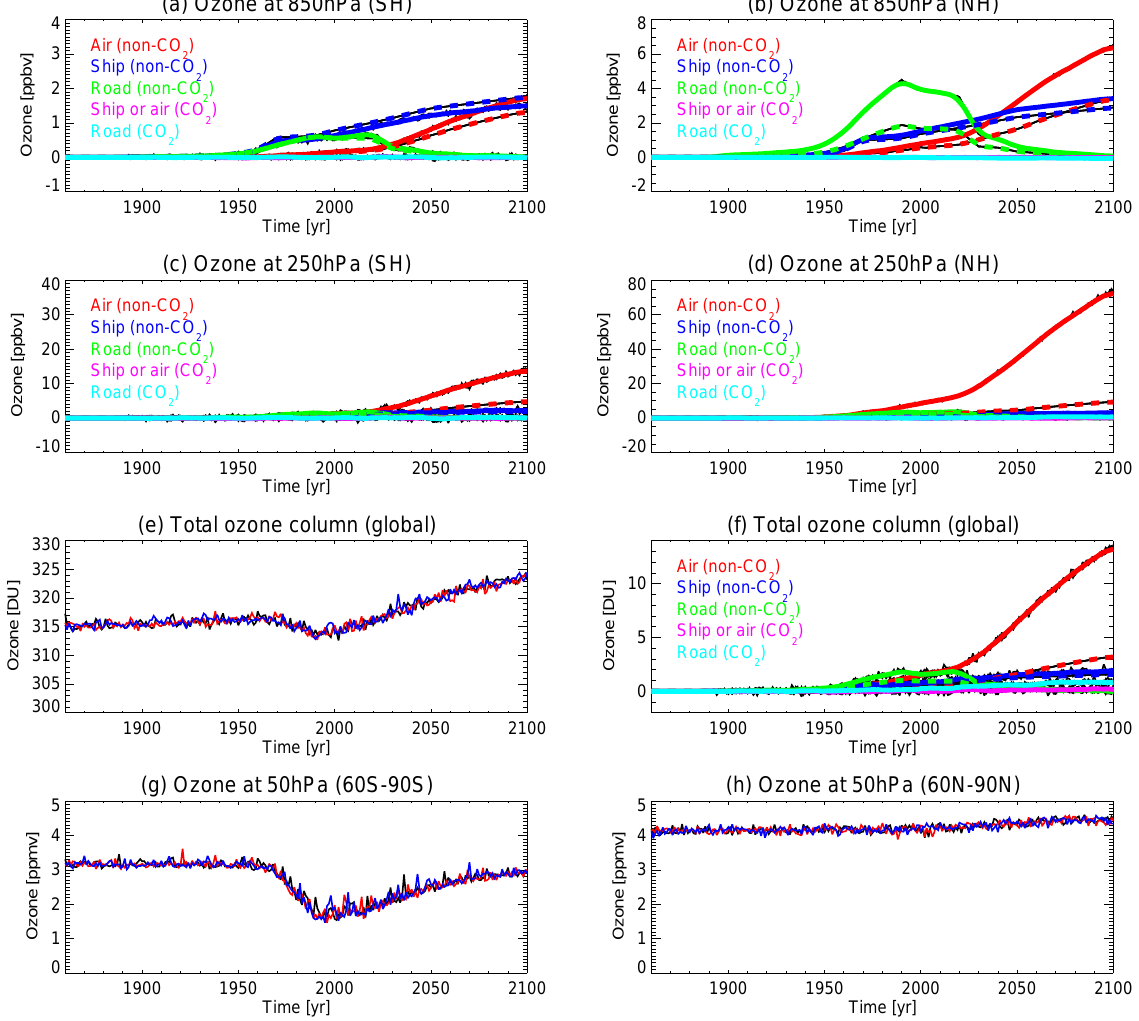
Fig. 6. Time series of the O 3 evolution: impact from the transport sectors on the O 3 mixing ratio at 850hPa in the (a) SH and (b) NH, and at 250hPa in the (c) SH and (d) NH; total O 3 column (e) in the reference simulation and (f) impact from the transport sectors; (g) O 3 mixing ratio in the reference simulation at 50hPa averaged over the 60–90 ◦ S region in September and (h) over the 60–90 ◦ N region in March. In (a) , (b) , (c) , (d) and (f) , full lines indicate the dynamical O 3 approach and dashed lines the fixed O 3 approach. In (e) , (g) and (h) , the three different lines (black, red and blue) represent the three different members of the ensemble.